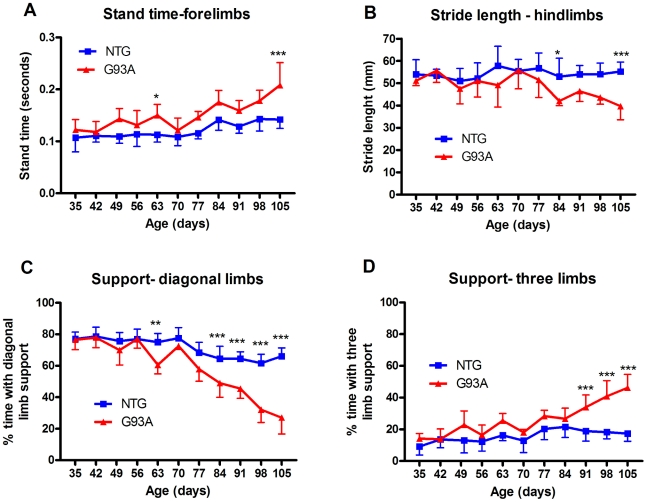
Analysis of individual gait parameters over time in SOD1G93A transgenic mice.Selected gait parameters from table 3 were subjected to two-way ANOVA with Bonferroni post-tests. Average stand time (a) in seconds, hindlimb stride length (b) in mm, use of diagonal support (% of time) and use of three limbs for support (% of time) +/− standard deviation for SOD1G93A mice versus non-transgenic (NTG) control mice at weekly intervals between 35 and 105 days of age are shown. Asterisks indicate p<0.05 (*), p<0.01 (**) and p<0.001 (***) using bonferroni post test following two-way ANOVA on raw data (a, b) or logit transformed data (c, d). The majority of differences were detectable post-onset of classical signs (∼75 days).